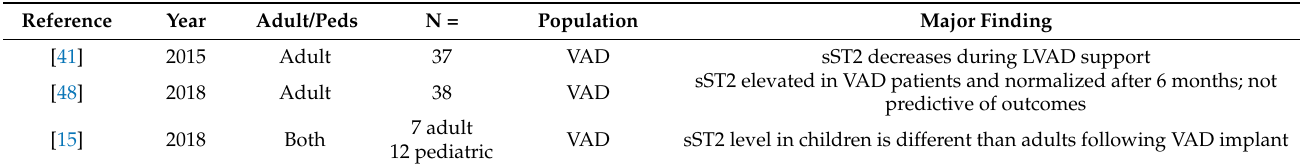
Table 3. Application of sST2 in adult and pediatric patients with heart failure requiring